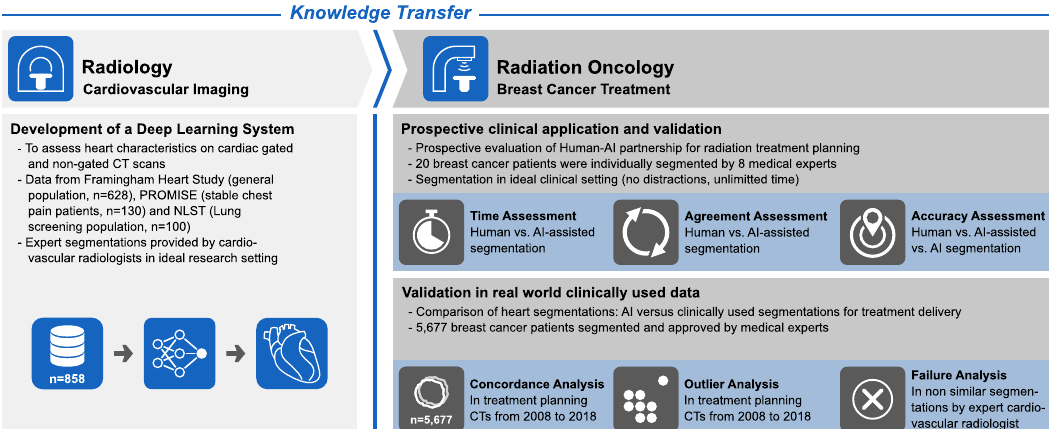
Fig. 1 Study overview. A 3D deep-learning system was developed in cardiovascular radiology using CT scans from distinct and well- established cohorts. For training, medical experts segmented the heart in cardiac gated and non-gated CT scans. This specialized knowledge embedded in the deep-learning system was then transferred to radiation oncology and used to support treatment planning in patients with breast